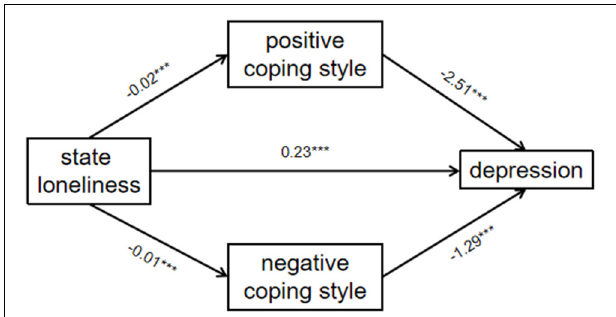
FIGURE 2 | The pathway of coping style to state loneliness and depression *** p < 0.001.